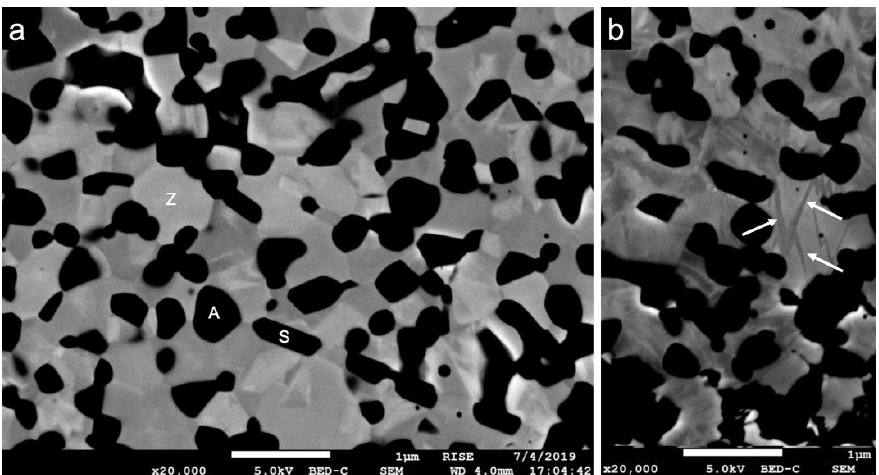
Figure 4. ( a ) SEM image ( × 20,000) showing the bulk material of the novel zirconia-based composite with pure alumina (A, dark equi-axial grains), strontium hexa-aluminate (S, dark elongated grains) and zirconia stabilized with cerium (Z, brighter grains). ( b ) SEM image ( × 20,000) displaying darker transformation bands in the zirconia grains after hydrothermal/mechanical treatment (white arrows).